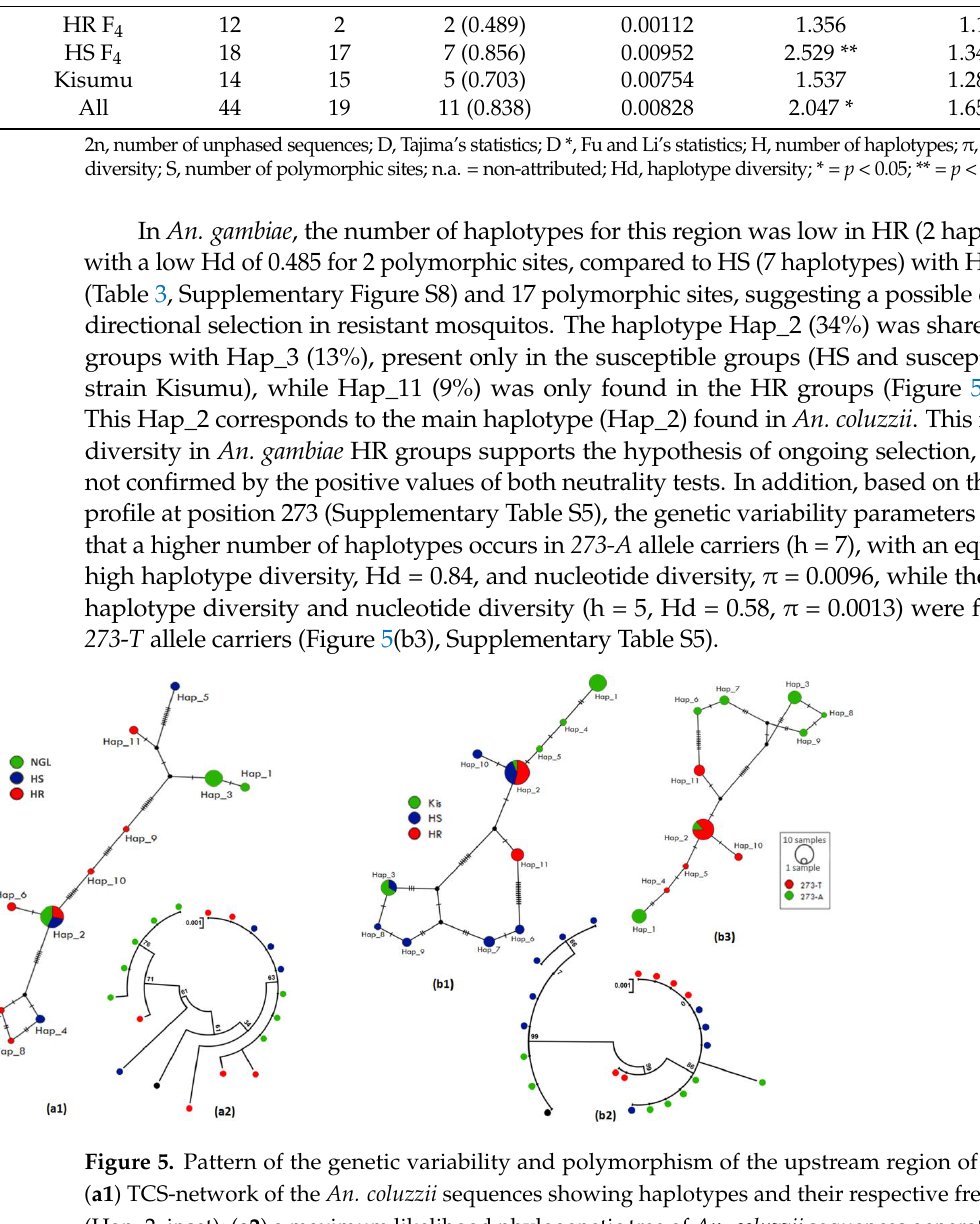
Figure 5. Pattern of the genetic variability and polymorphism of the upstream region of CYP6P4 . ( a1 ) TCS-network of the An. coluzzii sequences showing haplotypes and their respective frequencies (Hap_2, inset); ( a2 ) a maximum likelihood phylogenetic tree of An. coluzzii sequences generated using Kimura 2-parameter model; ( b1 ) TCS-network of the An. coluzzii sequences showing haplotypes and their respective frequencies for An. gambiae (Hap_2, inset); ( b2 ) a maximum likelihood phylogenetic tree of An. gambiae sequences generated using Juke- Cantor model. ( b3 ) TCS-network of the upstream region of CYP6P4 mutation per allele in An. gambiae . Hap, Haplotype; NGL, Ngousso lab strain; HR, Highly resistant; HS, Highly susceptible; Kis, Kisumu lab strain. Analysis of variability of a 1051 bp-fragment of the CYP6P4 -gene (1521 bp) was done on 58 individual sequences from An. coluzzii (9 HR, 10 HS, 10 Ngousso strain) and An. gambiae (10 HR, 9 HS, 10 Kisumu lab strain) (Supplementary Figure S7). In An. coluzzii , HR mosquitos showed a lower number of haplotypes (8) than the HS individuals (9) (Ta- ble 4, Supplementary Figure S9). The haplotype network analysis and phylogenetic tree for this fragment showed that the observed haplotypes are genetically diverse and do not cluster according to resistance phenotype (Figure 6(a1, a2)). However, Hap_2 was pre- dominant (14%) and shared by all sample groups tested, the others being distributed as shown in Figure 6(a1, a2b) below. The absence of predominant haplotypes indicates that this gene is not subject to selection pressure in An. coluzzii specimens from Yaoundé, Cam- eroon. The HR sequences of An. gambiae exhibited 11 polymorphic sites with 12 haplotypes (Table 4, Supplementary Figure S9). For the HS and Kisumu lab strain, sequences were most polymorphic with 13 and 16 polymorphic sites, respectively (Supplementary Figure S9). The maximum likelihood phylogenetic tree generated shows a small cluster associ- ated with HR mosquitos (4 out of 10 sequences) (Figure 6(b1, b2)). Hap_24 was predomi- nant (14%) followed by Hap_14 (5.2%) and Hap_19 (3.4%), shared by the HR and HS sam- ples. On the other hand, Hap_4 (5.2%) and Hap_10 (5.2%) were predominant in HS spec- imens or the Kisumu specimens.